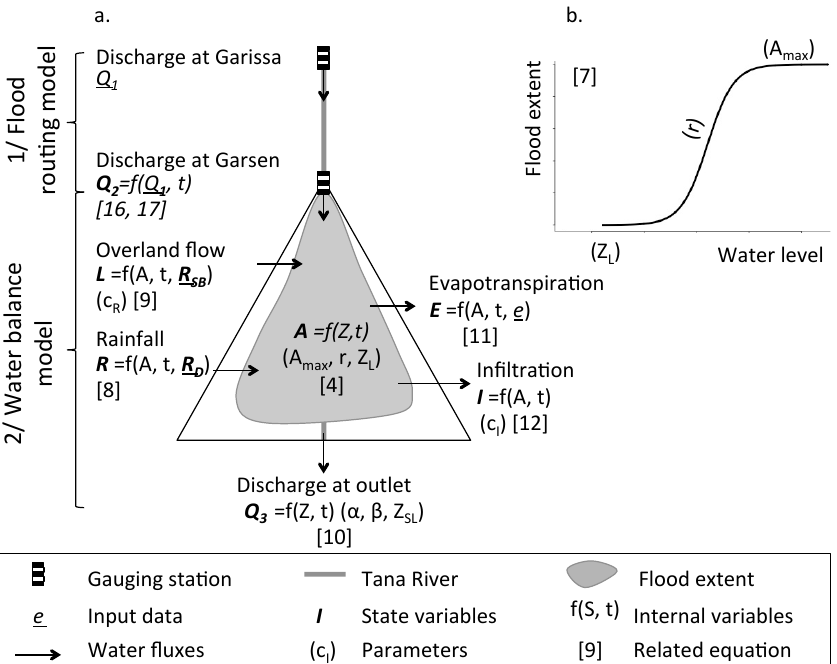
Fig. 3. (a) Schematic representation of the Tana Inundation Model. (b) Logistic equation type relating flood extent A to water level Z in the delta. Q 1 , Q 2 and Q 3 : discharges at Garissa, Garsen and the delta outlet; t : time; R , R D and R SB : rainfall over the flooded area, at TDIP and at Garissa; L : overland flow; E : evapotranspiration over the flooded area; e : potential evapotranspiration; I : infiltration from the flooded area; c R , A max , r , Z L , c I , α , β , and Z SL are model parameters defined in Table 3.